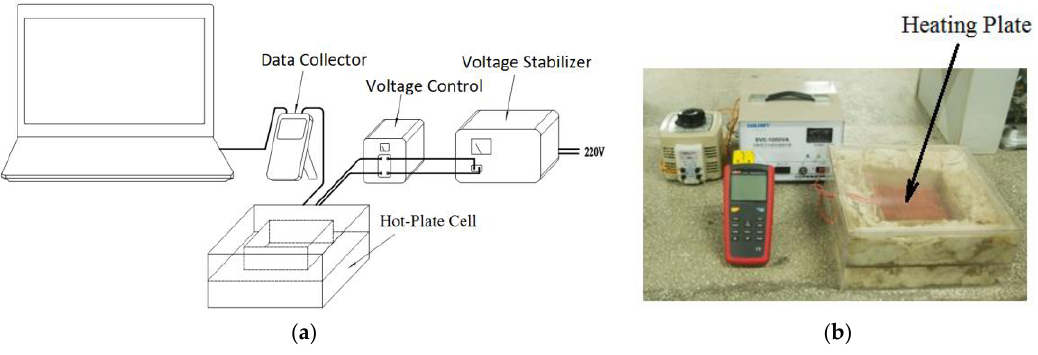
Figure 4. Hot-plate measuring system, ( a ) illustration; ( b ) products.